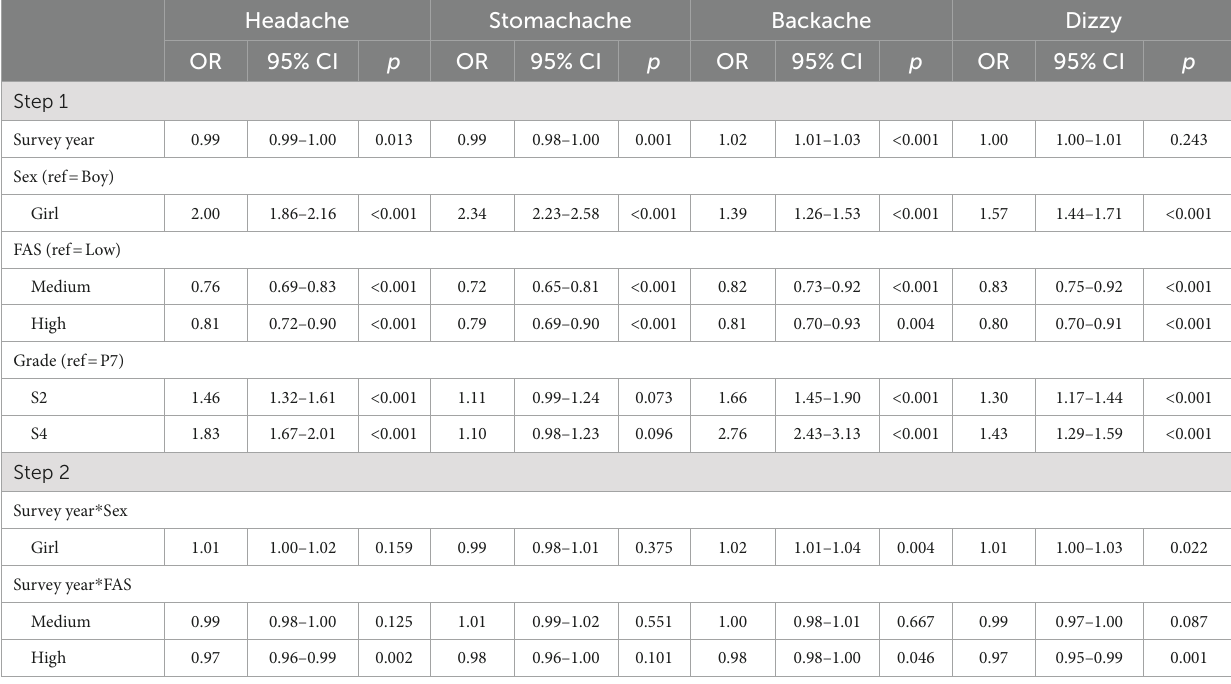
TABLE 4 Odds ratios of reporting weekly somatic symptoms.